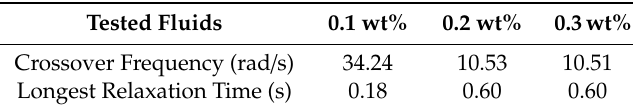
Table 2. Longest relaxation times for HELV